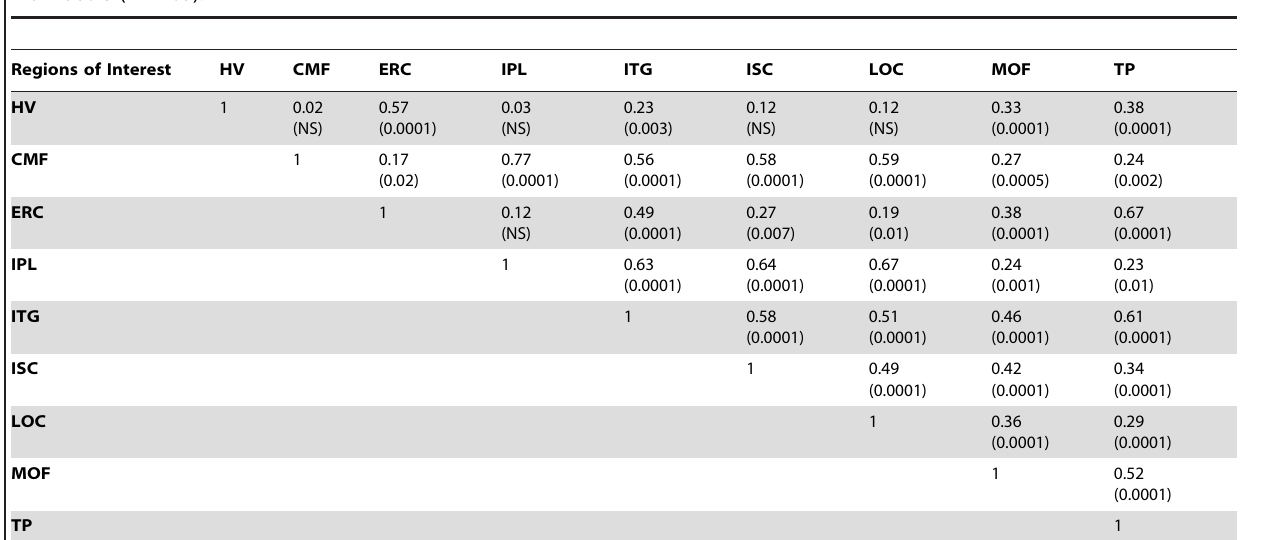
Correlations between regional neocortical thickness and hippocampal volume Overall, the hippocampus demonstrated the largest magnitude of correlation with the entorhinal cortex (Spearman’s r =0.66, p , 0.001), temporal pole (Spearman’s r = 0.51, p , 0.001), inferior temporal gyrus (Spearman’s r = 0.45, p , 0.001) and the medial portion of the orbital frontal cortex (Spearman’s r =0.41,